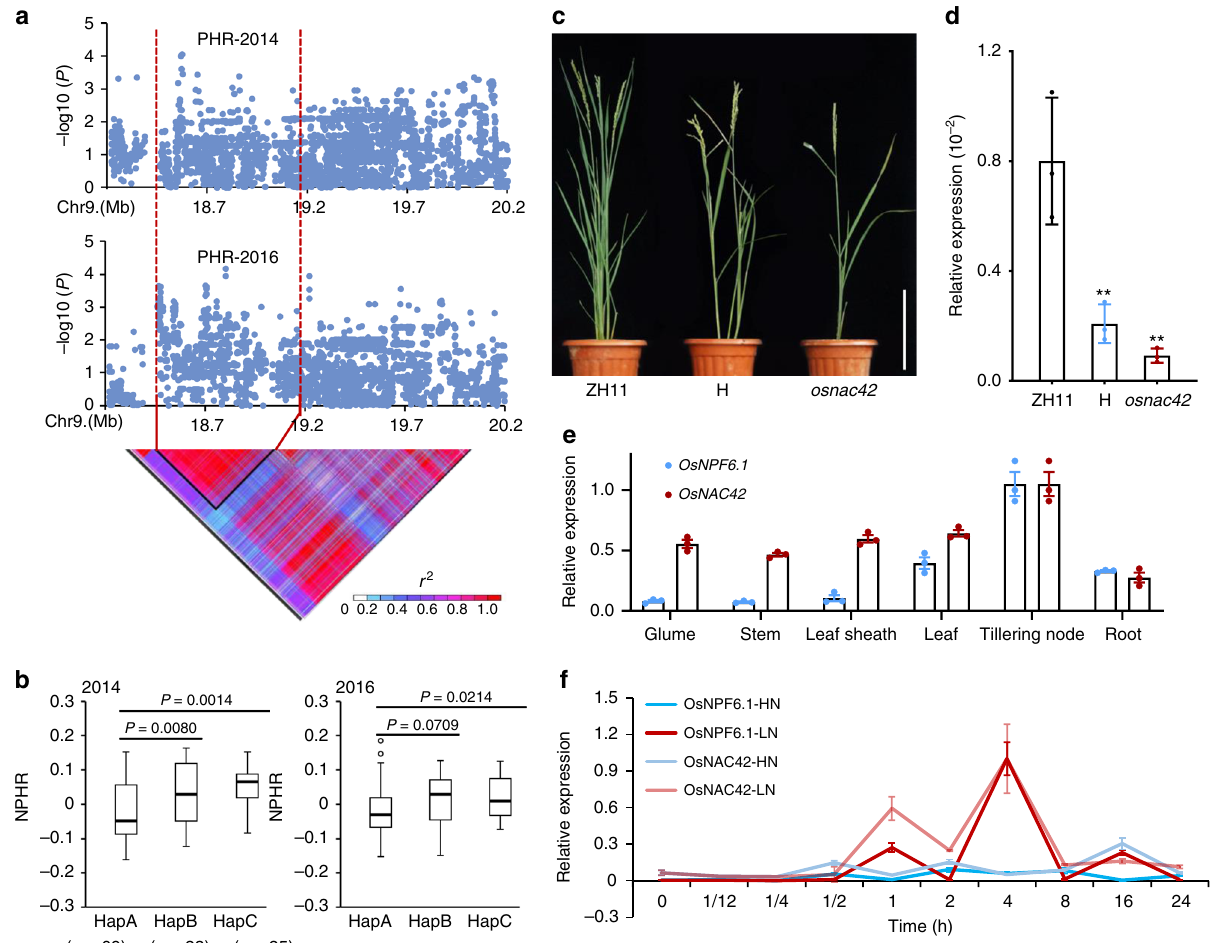
Fig. 4 Identi fi cation and functional validation of the transcription factor OsNAC42 on chromosome 9. a Local Manhattan plot (top) and LD heatmap (bottom) surrounding the peak on chromosome 9. Red dashed lines indicate the candidate region for the peak. b Comparative analyses of OsNAC42 between the low and high NUE haplotypes. Boxplots for NPHR (normalized plant height ratio)-2014 (top) and NPHR-2016 (bottom) based on the haplotypes (Hap) for OsNAC42 . Box edges represent the 0.25 quantile and 0.75 quantile with the median values shown by bold lines. Whiskers extend to data no more than 1.5 times the interquartile range, and remaining data are indicated by dots. Differences between the haplotypes were analyzed by Welch ’ s t test. c Phenotype of WT (Zhonghua11, ZH11), Tilling mutant ( osnac42 ) and heterozygote (H), bar = 20 cm. d qRT-PCR analysis of OsNPF6.1 of WT (Zhonghua11, ZH11), Tilling mutant ( osnac42 ) and heterozygote (H). Three biological replicates were used for qRT-PCR. e OsNPF6.1 and OsNAC42 transcript levels in different tissues. OsActin1 was used as a control, n = 3. f OsNPF6.1 and OsNAC42 expression under HN treatment from 0 to 24 h in